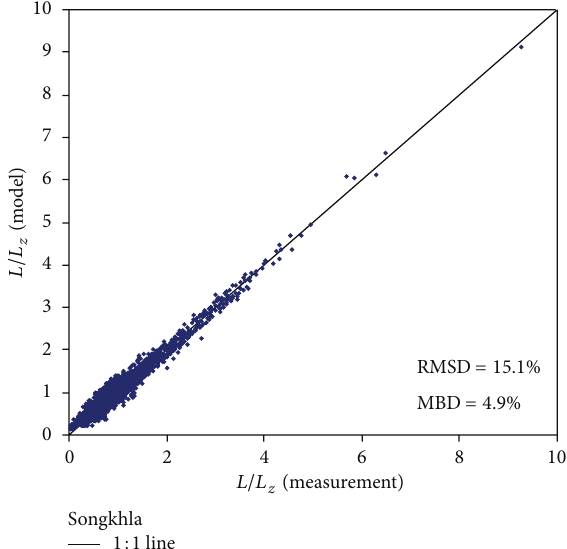
Figure 13: Comparison between the relative sky luminance calcu- lated from the model 𝐿/𝐿 𝑧 model and that obtained from the 𝐿/𝐿 𝑧 measurement for Songkhla.